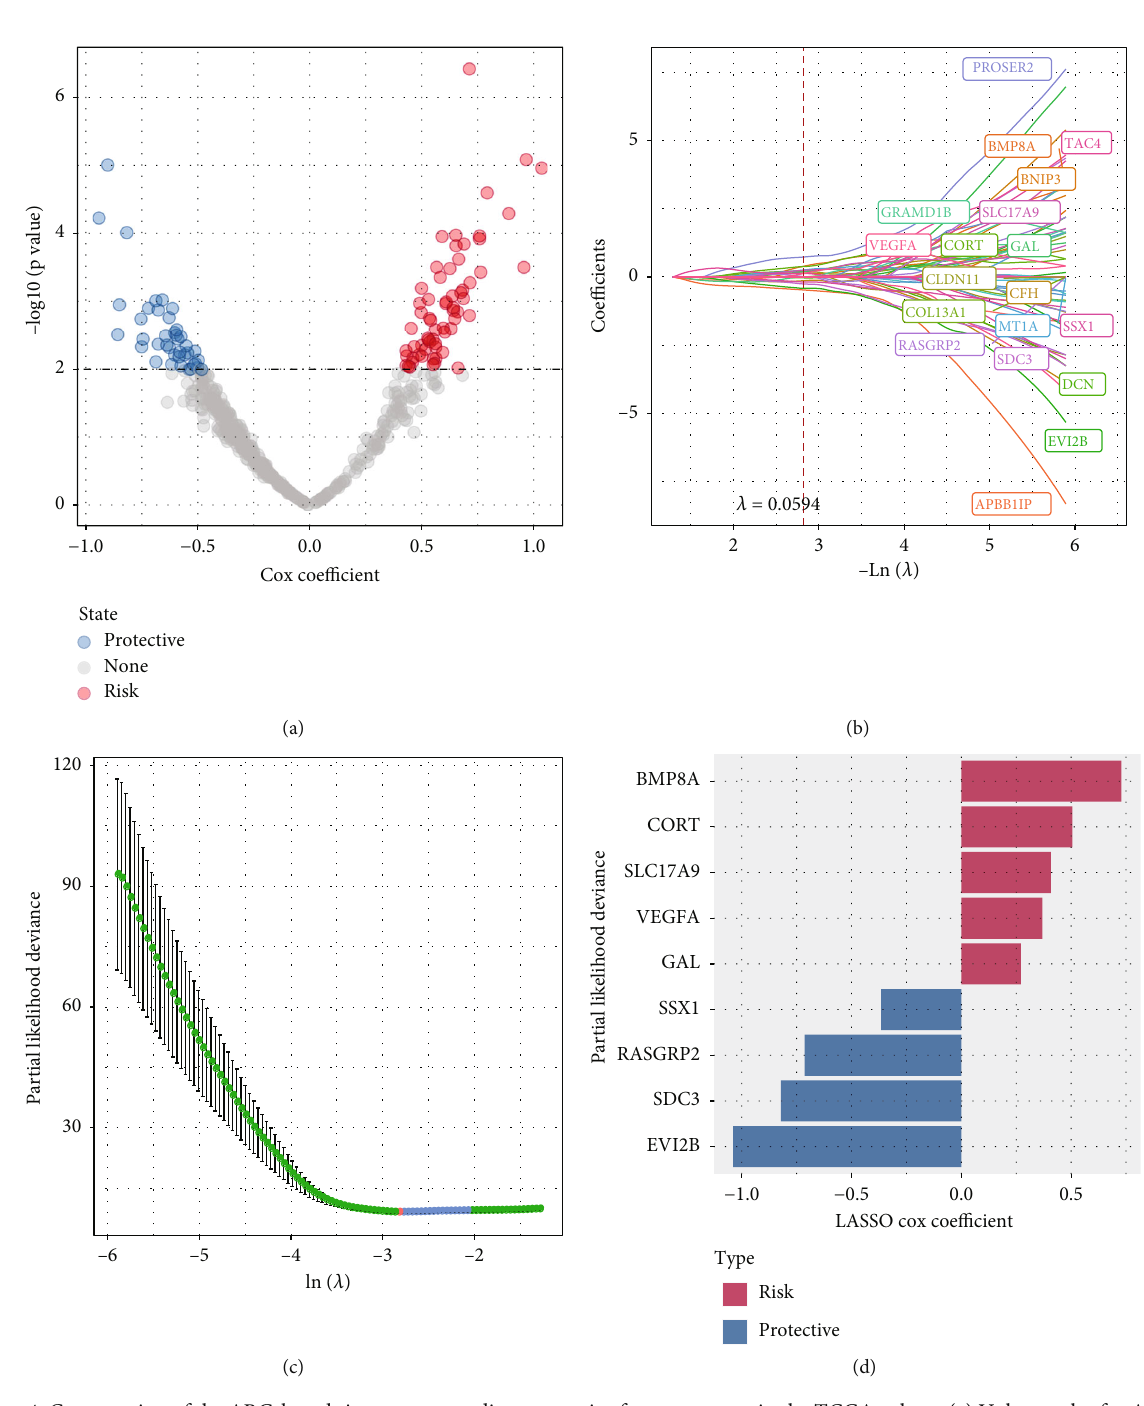
Figure 4: Construction of the ARG-based signature to predict prognosis of osteosarcoma in the TCGA cohort. (a) Volcano plot for ARGs in osteosarcoma. (b) The LASSO analysis was used to identify the prognostic variables and develop the predictive models. (c) Plots of the produced coe ffi cient distributions for the logarithmic (lambda) series for parameter selection (lambda). (d) Multivariate Cox regression identi fi cation of an ARG-based risk signature for osteosarcoma prognosis